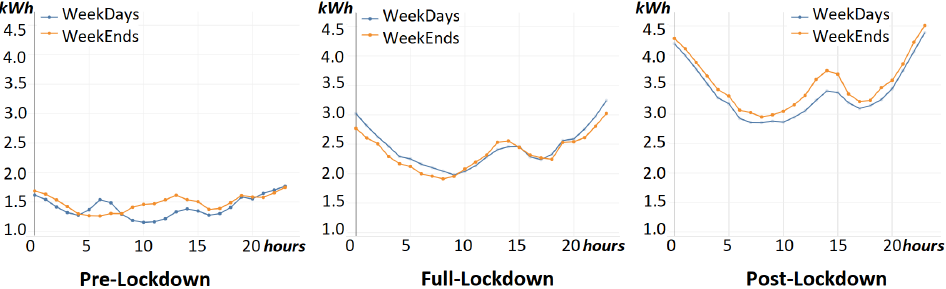
Figure 12. Comparison of weekends vs. weekdays mean hourly consumption profile be- fore/during/and after the lockdown in 2020.